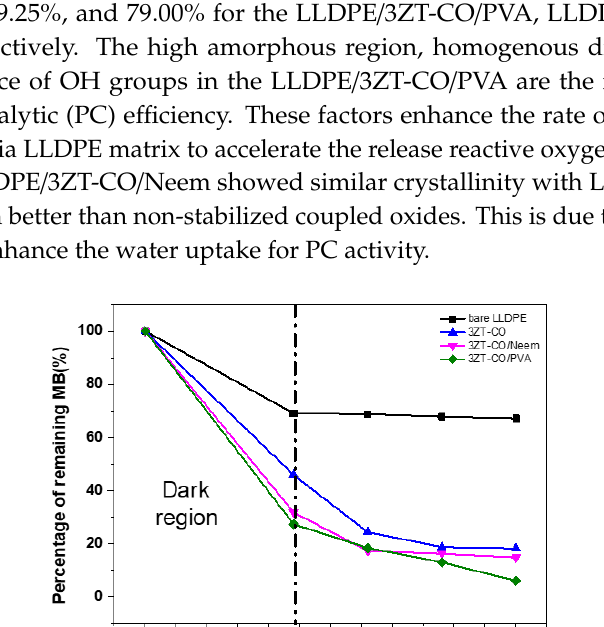
Table 4. Comparison of effluent parameters before and after treatment with LLDPE/3ZT-CO/PVA.